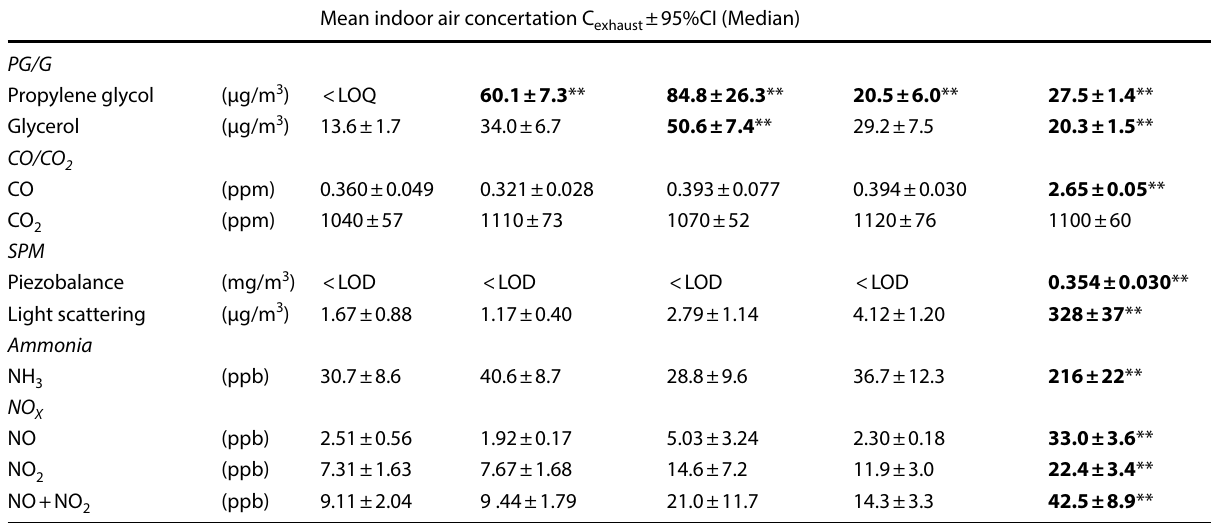
The constituents evaluated as “Status1” displayed in bold **Status1, “Actual indoor air concentration increase (“ > With person”)”, shown in Sect. 2.7 *Status2, “Not actual indoor air concentration increase”, shown in Sect.